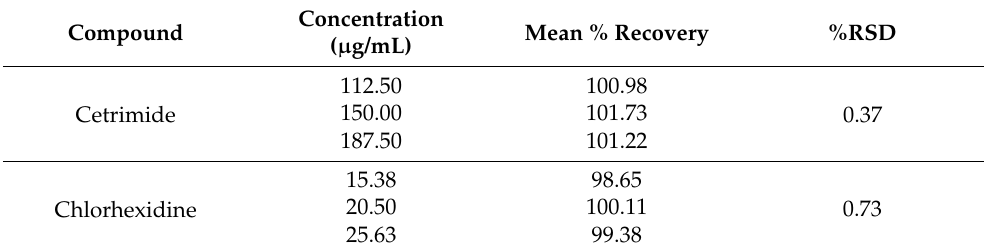
Table 4. Accuracy results obtained for three concentration levels.